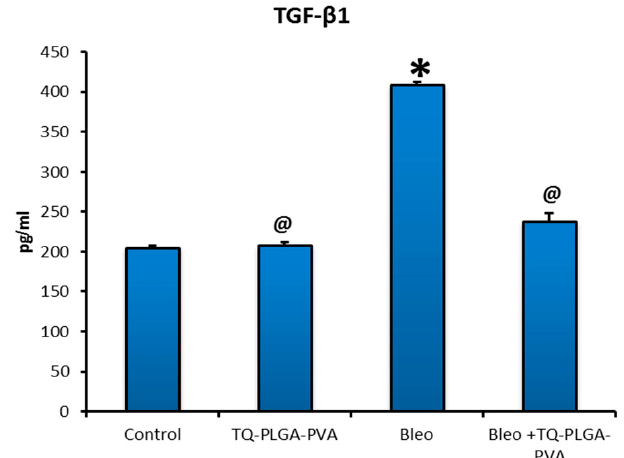
Figure 5. The e ff ect of TQ-PLGA-PVA-NPs on levels of transforming growth factor beta 1 (TGF- β 1) in bleomycin-induced pulmonary fibrosis in rats’ lungs. Results are presented as means ± SEs. Statistical analyses were achieved using one-way ANOVA, followed by Duncan’s multiple range test. * p < 0.05 compared with the normal control. @ p < 0.05 compared with the bleomycin-treated rats.